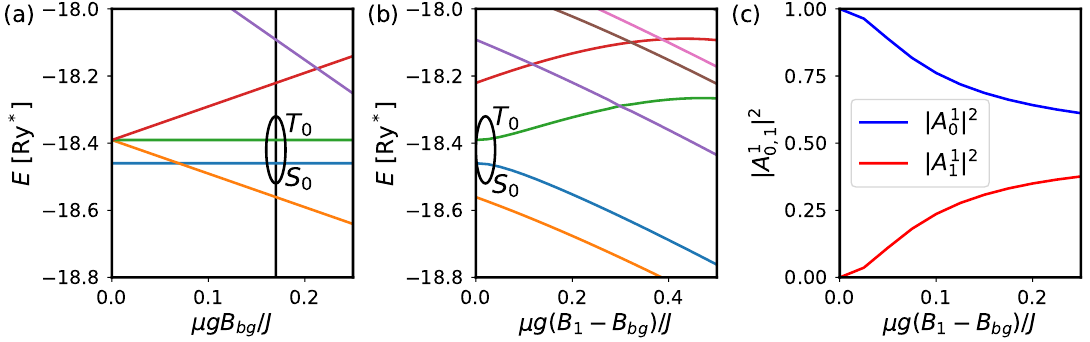
Figure 2. The idea of the singlet-triplet qubit based on the effective spin-1 chain. ( a ) the evolution of the energy spectrum of n = 14 chain with increasing background magnetic field B bg , allowing for isolating the two levels | S 0 (cid:105) and | T 0 (cid:105) . The vertical black line denotes µ gB bg / J = 0.17; ( b ) the energy spectrum as a function of the local magnetic field B 1 on the leftmost dot. The singlet and triplet states mix, forming | S (cid:105) + A i | T (cid:105) , with i = 0,1; ( c ) the probability density in the | a states | a i (cid:105) = A i 0 0 0 1 basis, as a function of B 1 . The spectra are obtained using the exact diagonalization